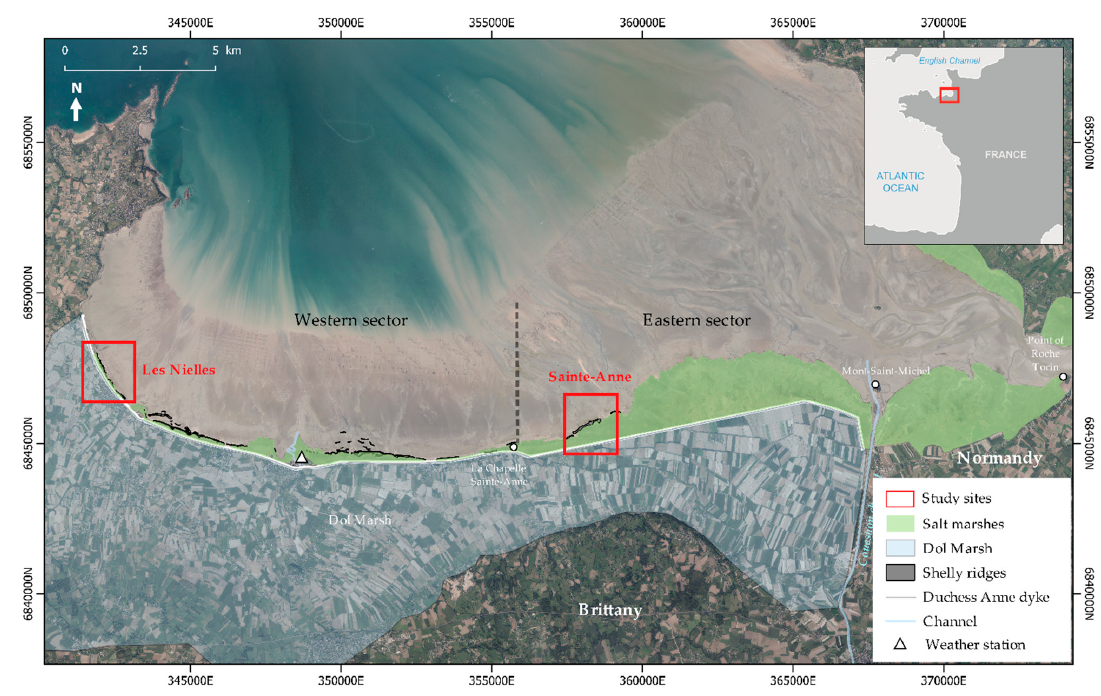
Figure 1. Overview of the Bay of Mont-Saint-Michel.